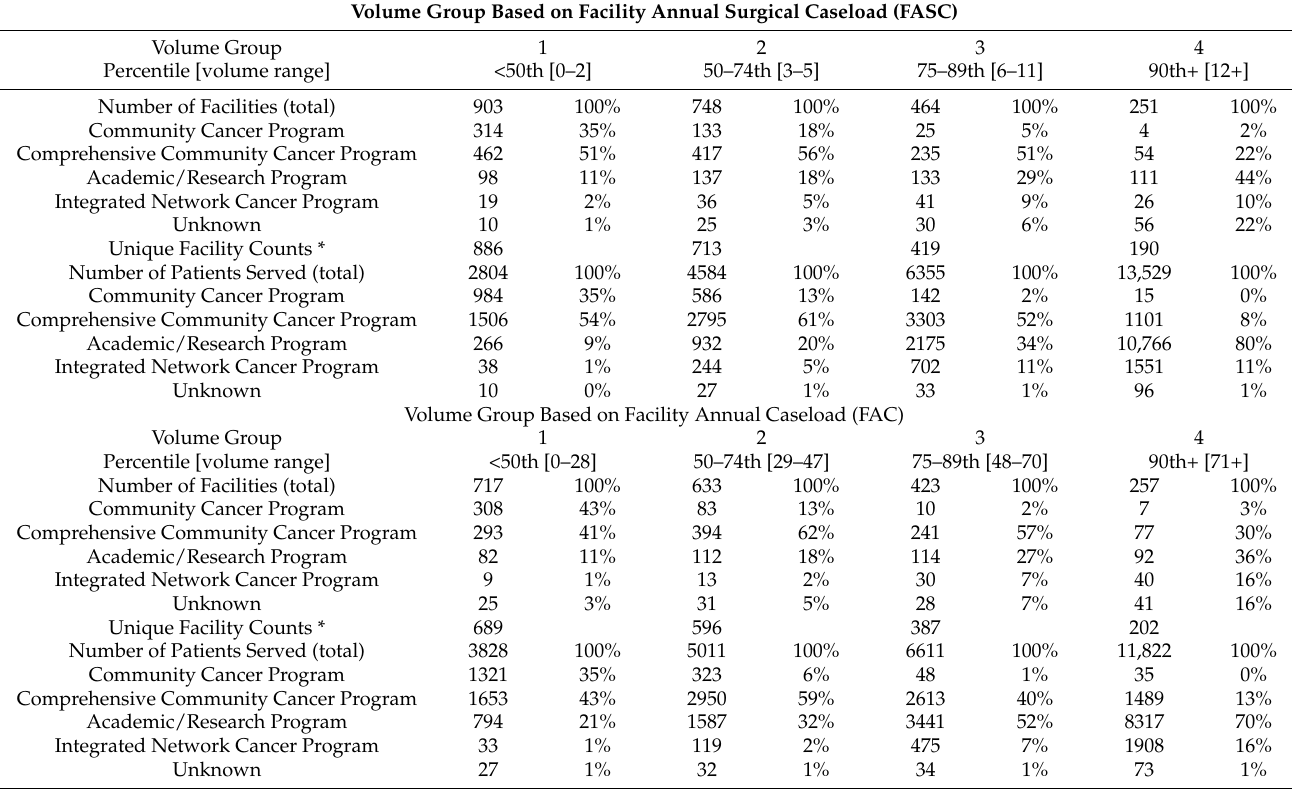
Table 2. Facility characteristics and distribution of radical cystectomies based on volume